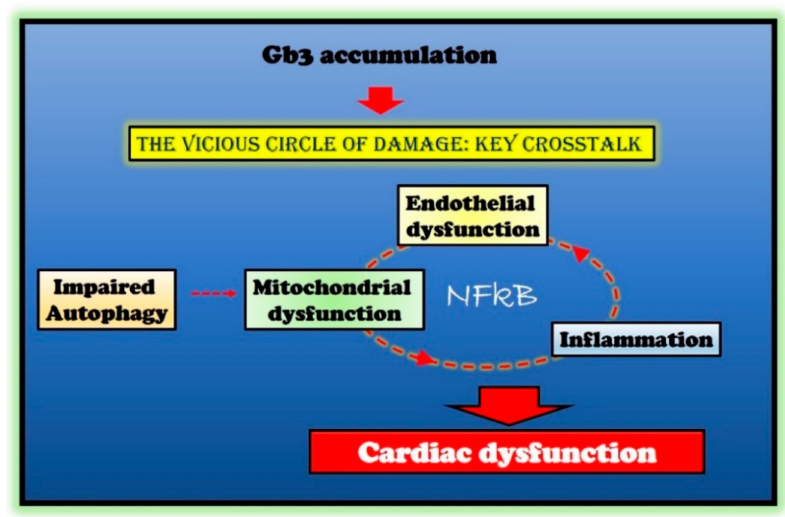
Figure 2. Molecular mechanisms in Fabry disease (FD) cardiac damage. Globotriaosylceramide (Gb3) accumulation in Fabry disease impairs several critical processes within the cell (autophagy and endothelial and mitochondrial function) and induces an inflammatory state. The crosstalk between these impaired conditions is responsible for cardiac damage in Fabry patients. The nuclear factor kappa-light-chain-enhancer of activated B cells (NF κ B) represents the critical node in this vicious circle of